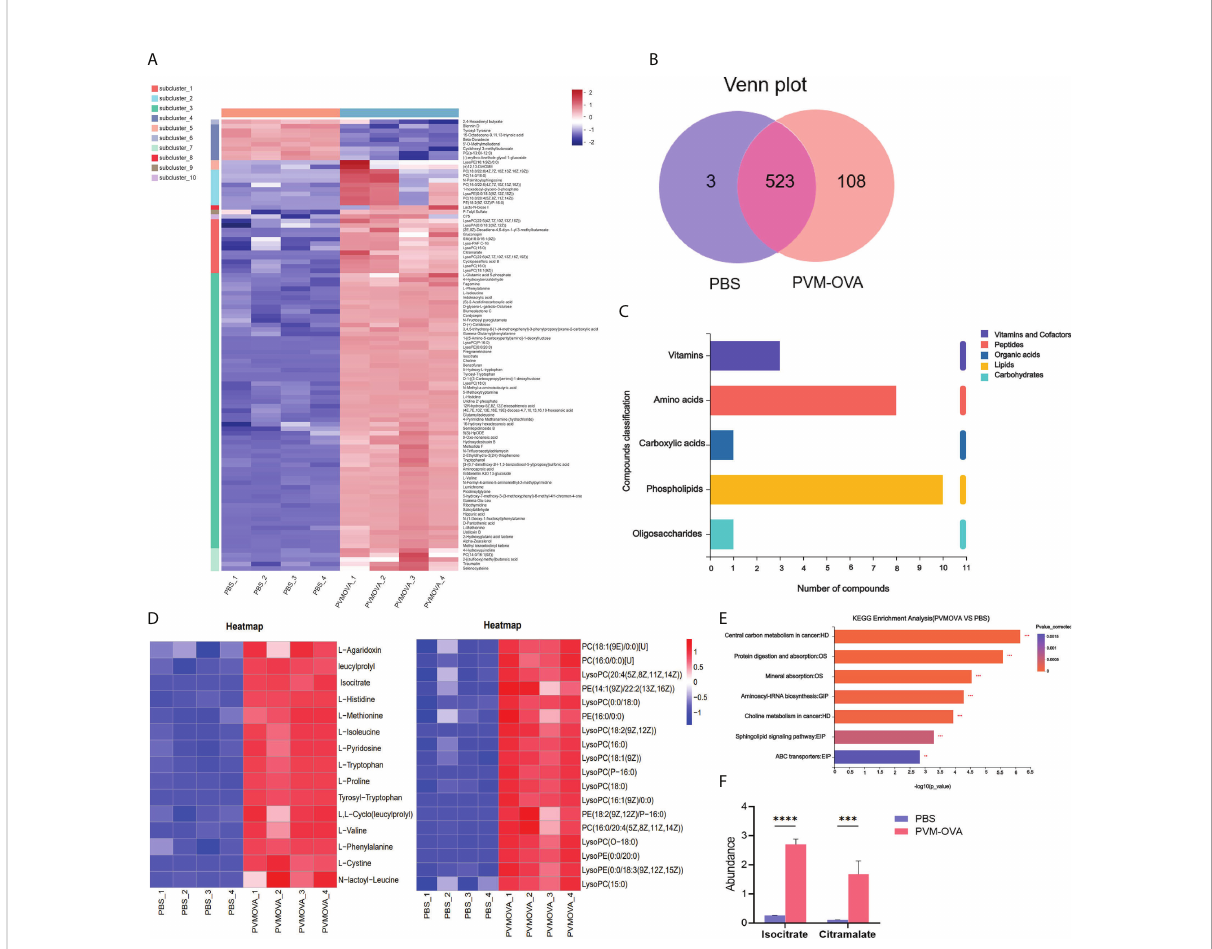
FIGURE 3 Lung CD11b + trained macrophages undergo metabolic reprogramming. (A) Heat map of differential metabolites of PVM-OVA group vs PBS group. (B) Venn plot of the numbers of different metabolites among groups. The diagram shows overlapping and distinct metabolites indicated by the numbers in the intersections and circles, respectively. (C) KEGG compound classi fi cation of differential metabolites. (D) Heat maps of differential metabolite amino acids or phospholipids. (E) KEGG pathway enrichment analysis. (F) The abundance of metabolites related to TCA cycle. ***P<0.001,